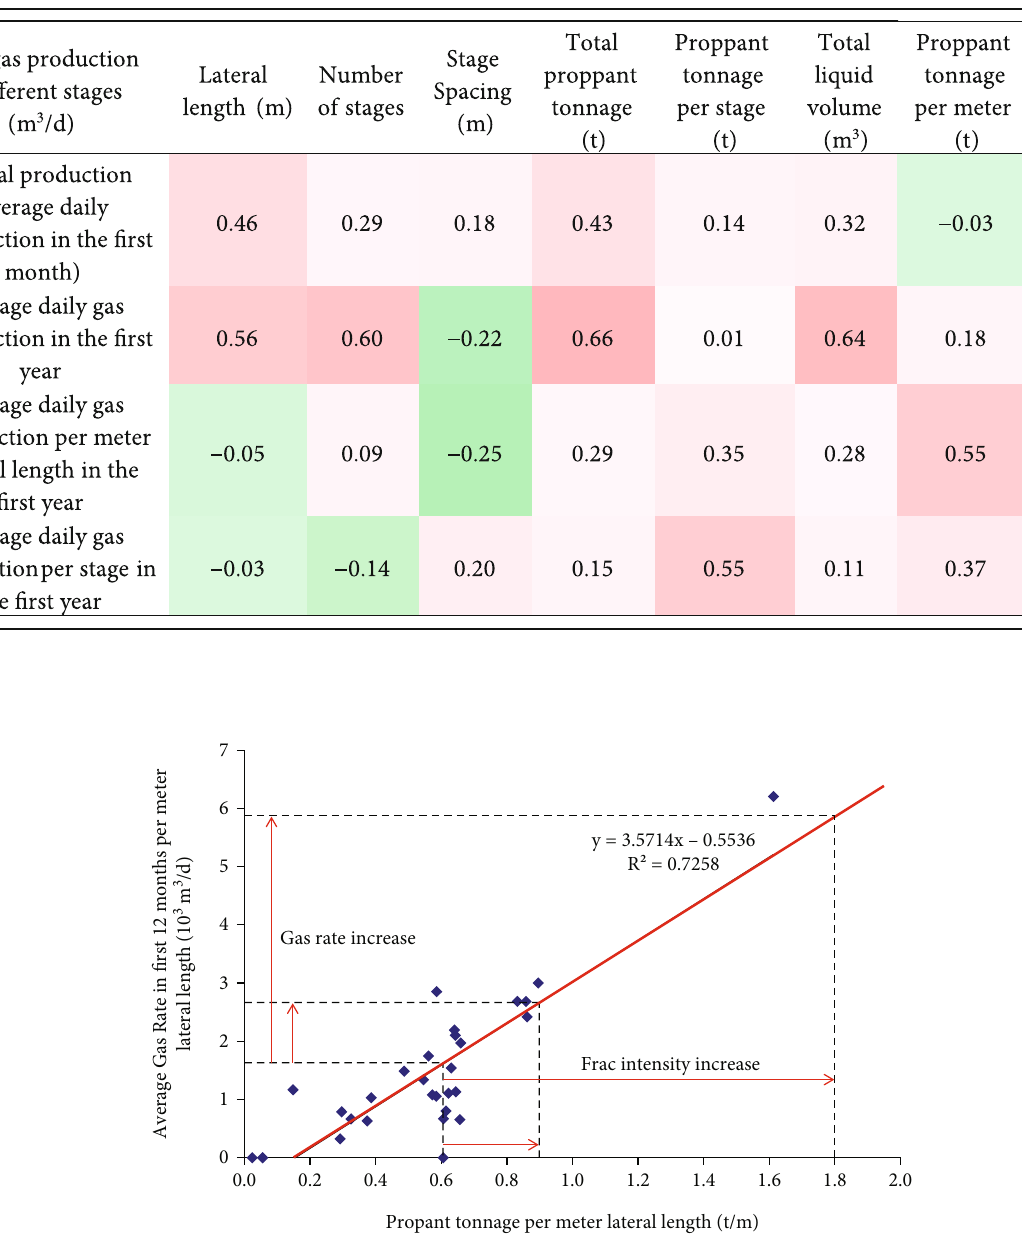
Figure 5: Correlation between production and proppant per meter in the upper layer in the S